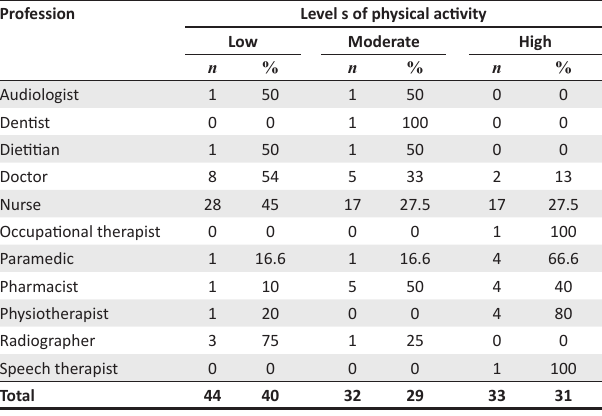
TABLE 3: Profession versus level of physical activity.